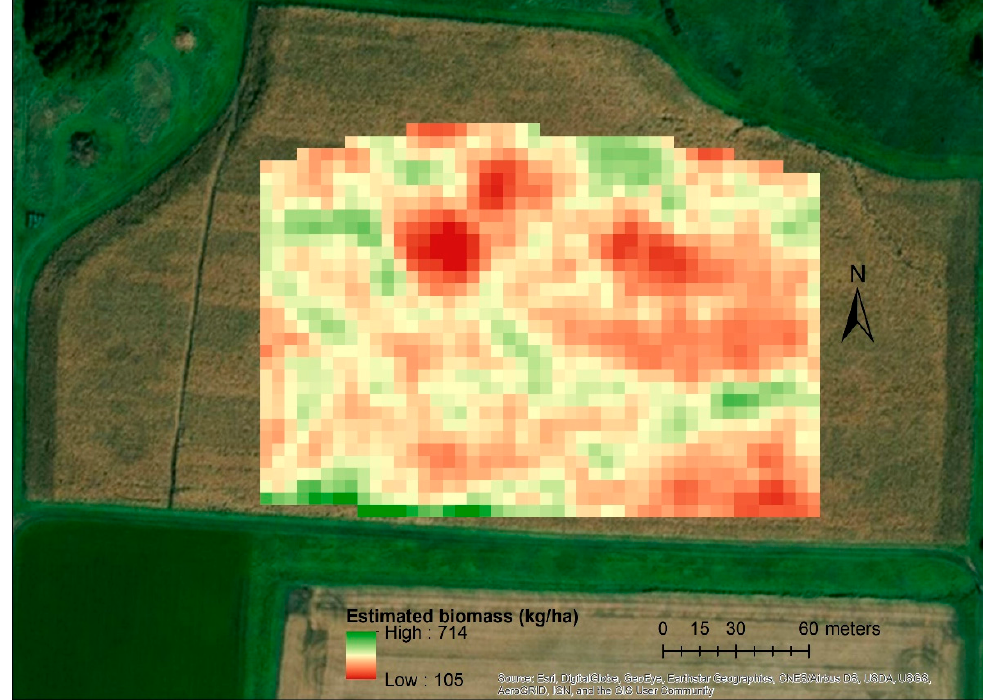
Figure 5. Spatial variability in maize biomass at the five leaf collar stage estimated using NDVI values from RapidEye satellite imagery.